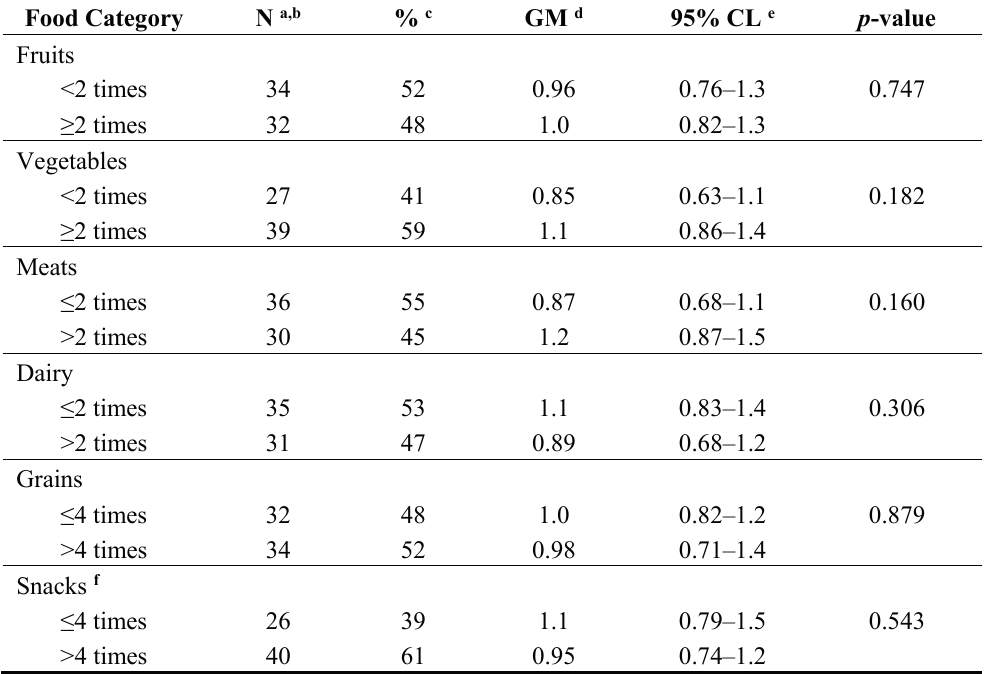
Table 3. Urinary PCP levels (ng/mL) in the home group of children by food consumption category a .